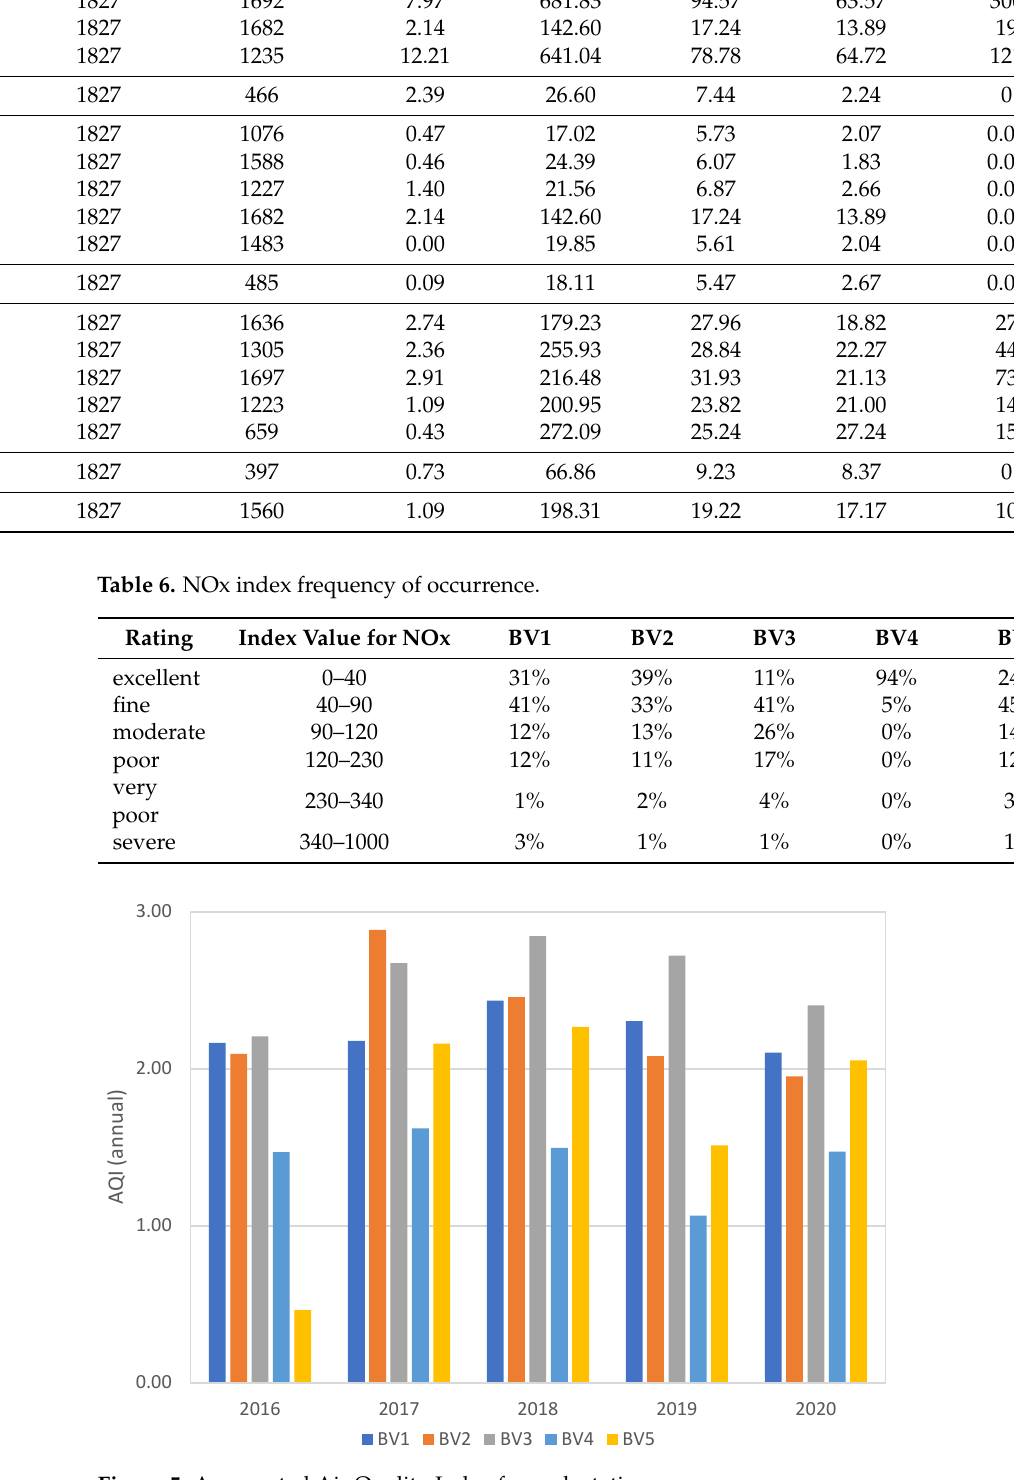
Figure 5. Aggregated Air Quality Index for each station.